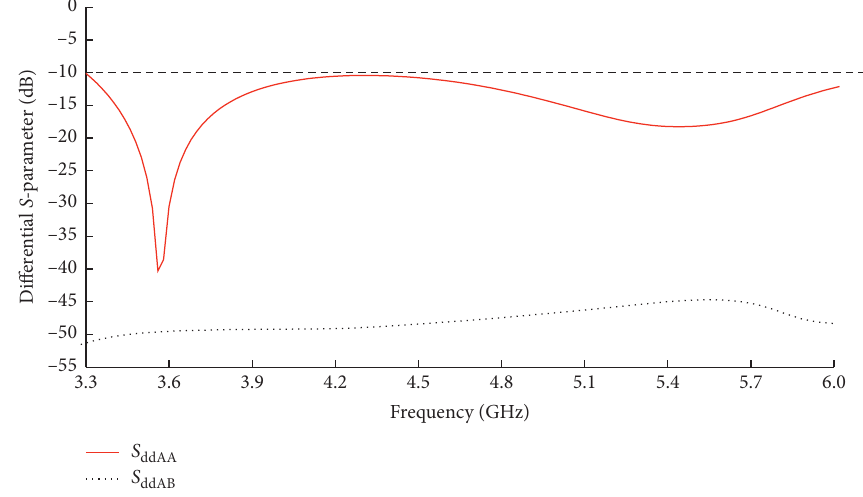
Figure 7: Simulated differential ( S )-parameters of proposed antenna.